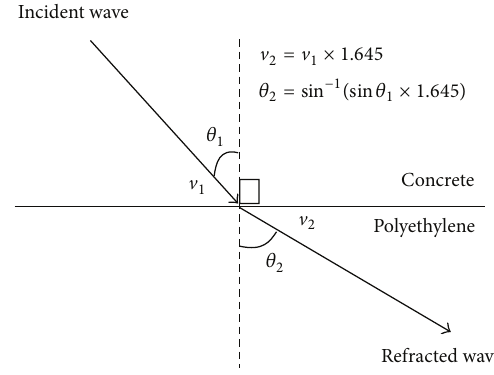
Figure 16: Refraction of wave from concrete medium to polyethy- lene medium.